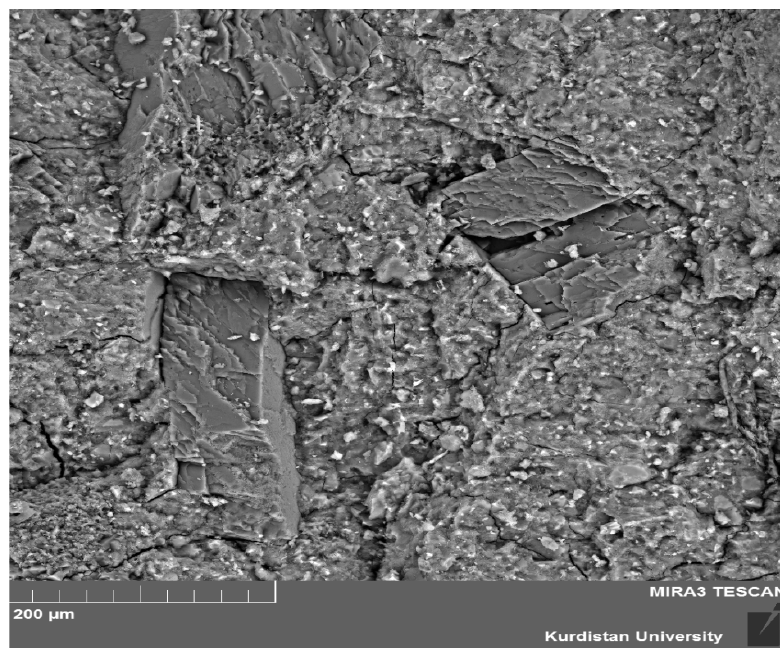
Crystals 2021 , 11 , x FOR PEER REVIEW Figure 9. SEM of RCA-NS 30% sample at 28 days. Figure 9. SEM of RCA-NS 30% sample at 28 days.